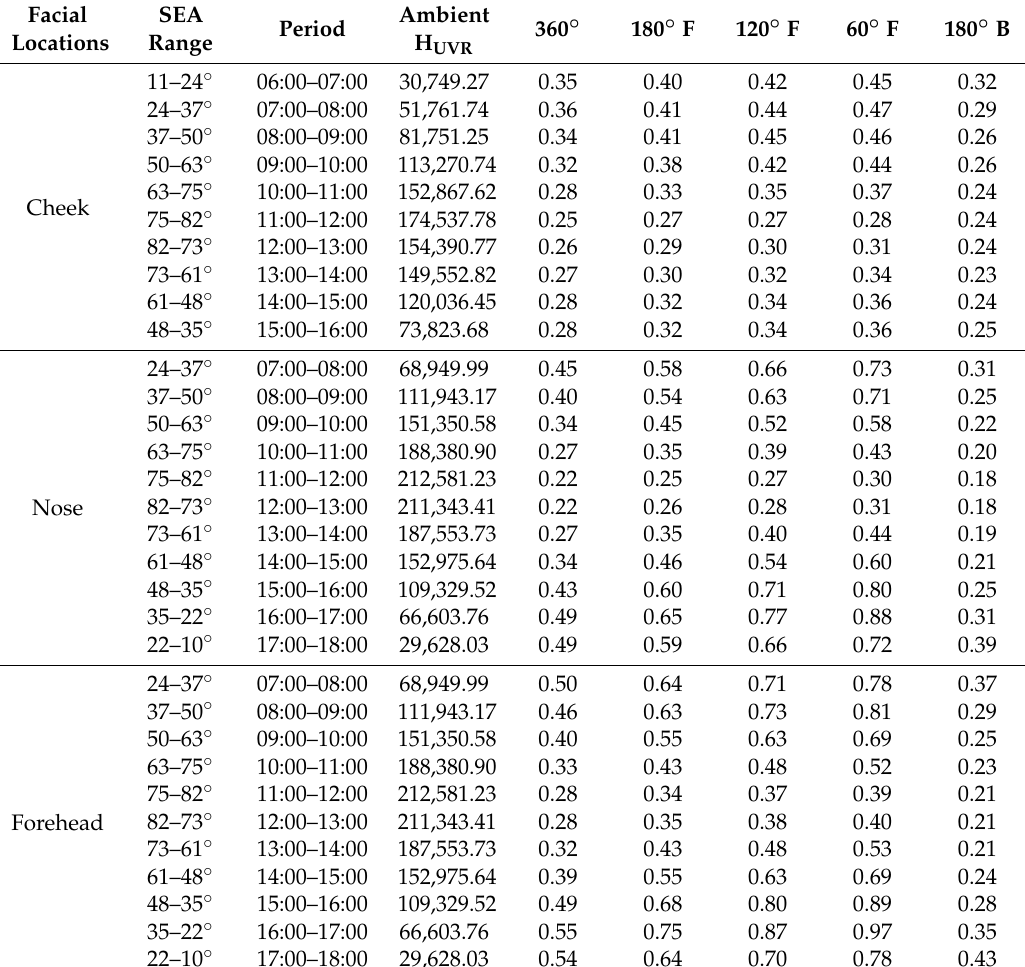
Table 1. The exposure ratios of the cheek, nose, and forehead after averaging H UVR (in J m − 2 ) for the different rotation angle ranges to the ambient H UVR (in J m − 2